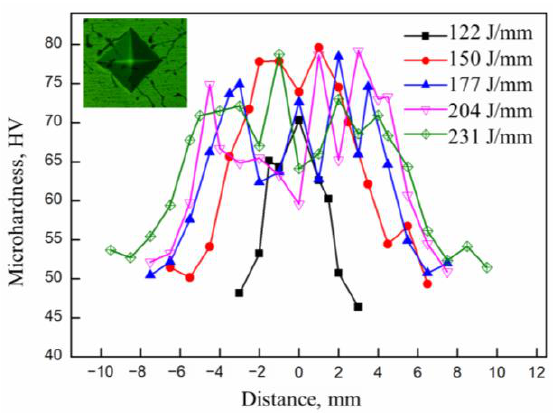
Figure 17. Microhardness of the samples with various heat input.